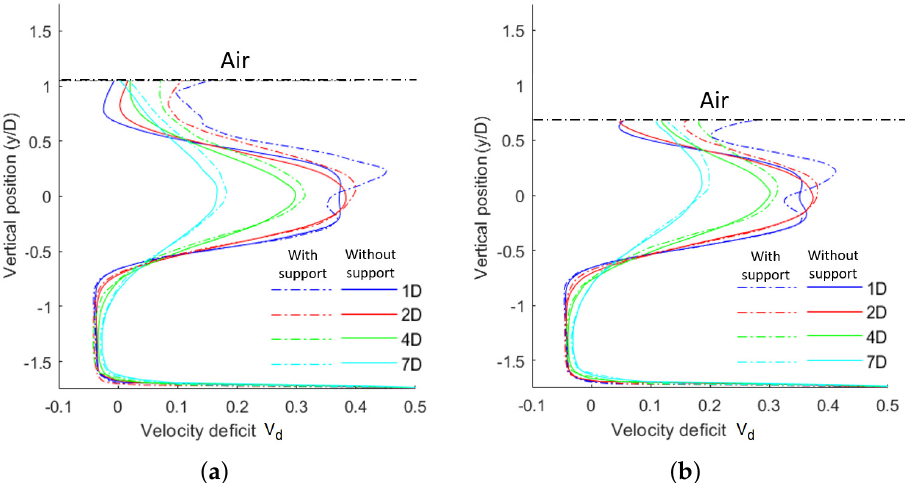
Figure 11. Comparison of time-averaged velocity deficit profiles at four downstream positions of the HAHT at λ = 6. ( a ) Deep tip immersion (0.55 D ); ( b ) Shallow tip immersion (0.19 D